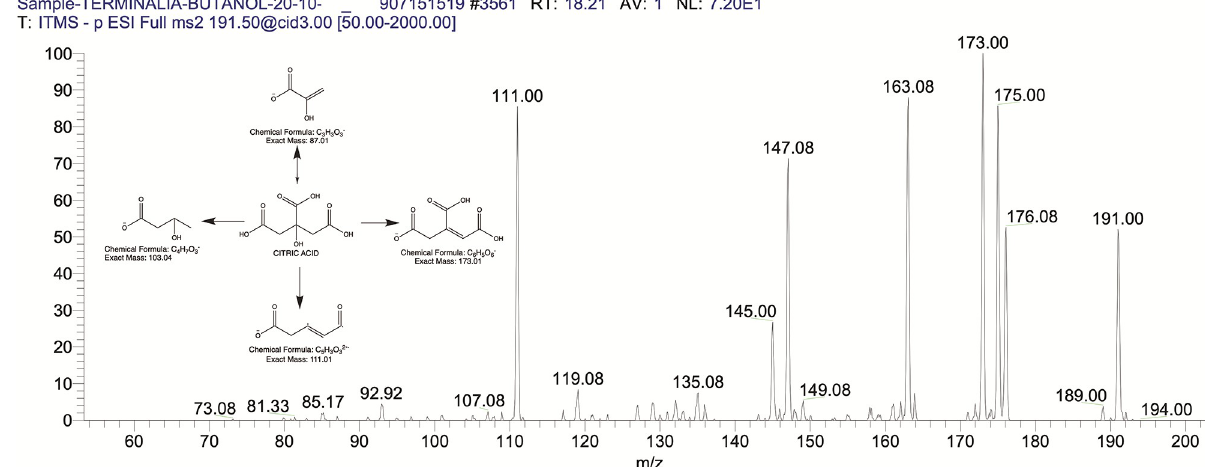
Fig 16. The mass spectrum of citric acid and its fragmentation